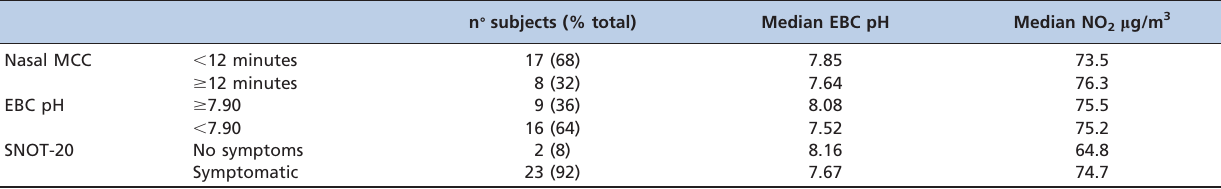
Table 2 - Nasal mucociliary clearance (MCC), exhaled breath condensate (EBC) pH and reports of airway symptoms based on the Sino-Nasal Outcome Test (SNOT-20) questionnaire (columns: frequencies of subjects, median values of EBC pH and personal nitrogen dioxide (NO 2 )